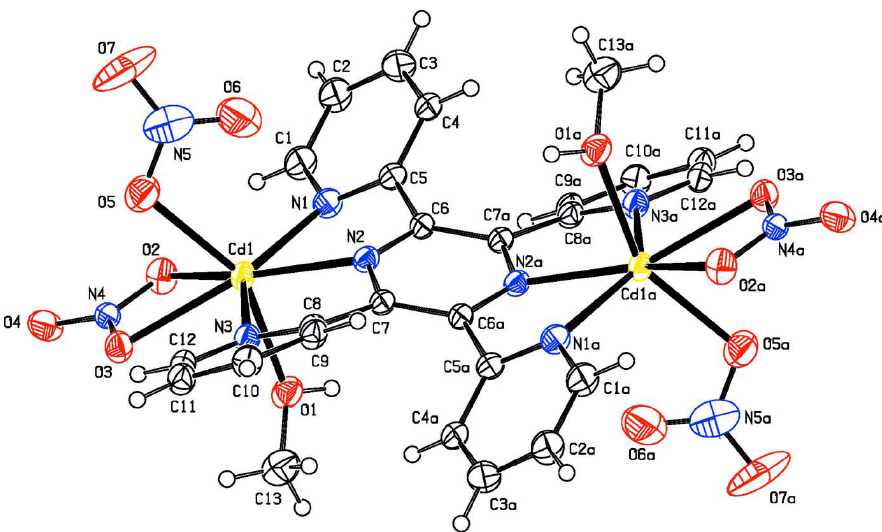
Figure 1 The molecular structure of the title molecule, with the atom-numbering scheme. Displacement ellipsoids are drawn at the 40% probability level [symmetry code: (a) 1 - x, -y, -z].